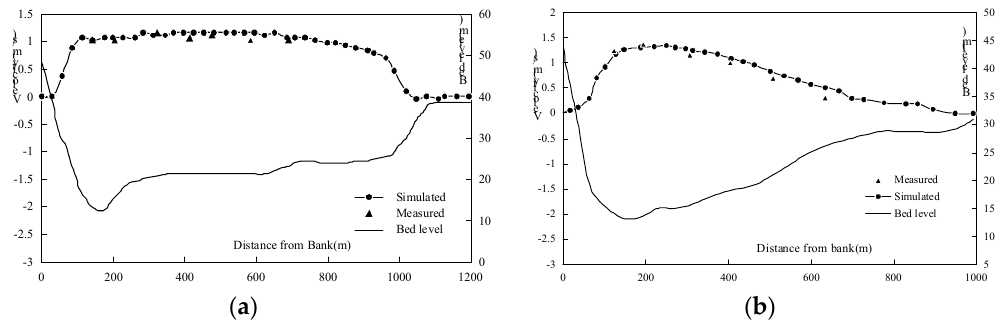
Figure 2. Measured and calculated cross-sectional profiles of depth-averaged velocity. ( a ) cross section S1; ( b ) cross section S2.